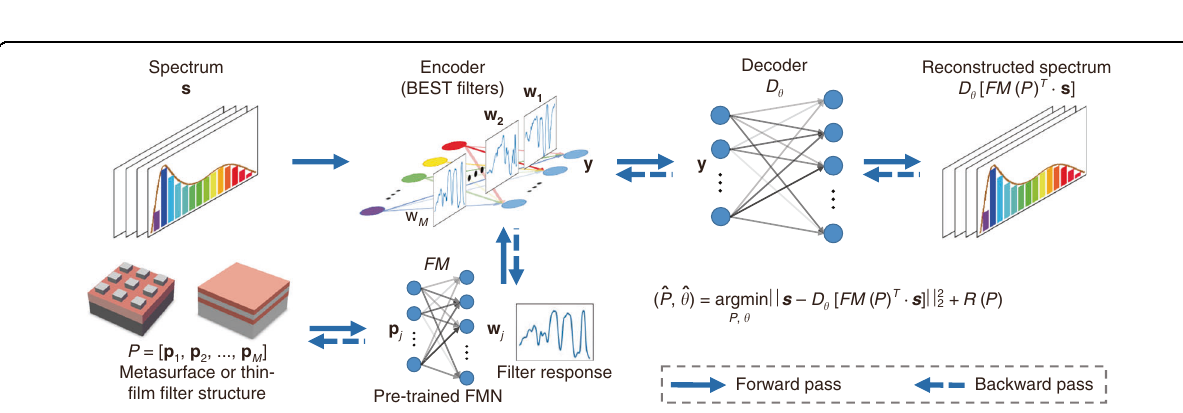
Fig. 9 Schematic of the PCSED framework. The broadband encoding stochastic (BEST) fi lters act as an encoding neural network (encoder), where the learned weights is the fi lter responses. The weights are constrained by the fi lters' structure parameters, and are generated from a pre-trained structure-to-response forward modeling network (FMN). The fi gure is reprinted from ref. 84 under a CC BY license (Creative Commons Attribution